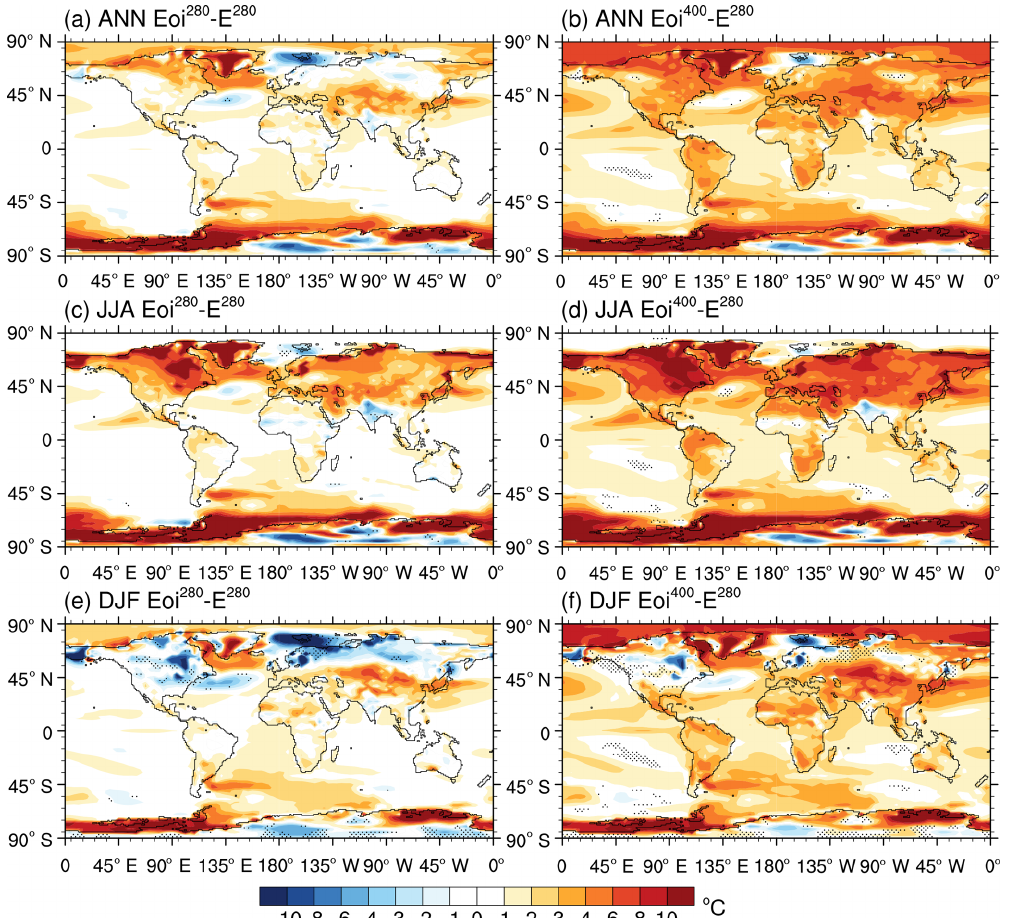
Figure 4. Mean annual and seasonal Pliocene temperature anomalies against E 280 . (a) Annual Eoi 280 –E 280 , (b) annual Eoi 400 –E 280 , (c) June–July–August (JJA) Eoi 280 –E 280 , (d) JJA Eoi 400 –E 280 , (e) December–January–February (DJF) Eoi 280 –E 280 and (f) DJF Eoi 400 – E 280 . Stippling indicates regions in which results are not statistically significant at a 95% confidence